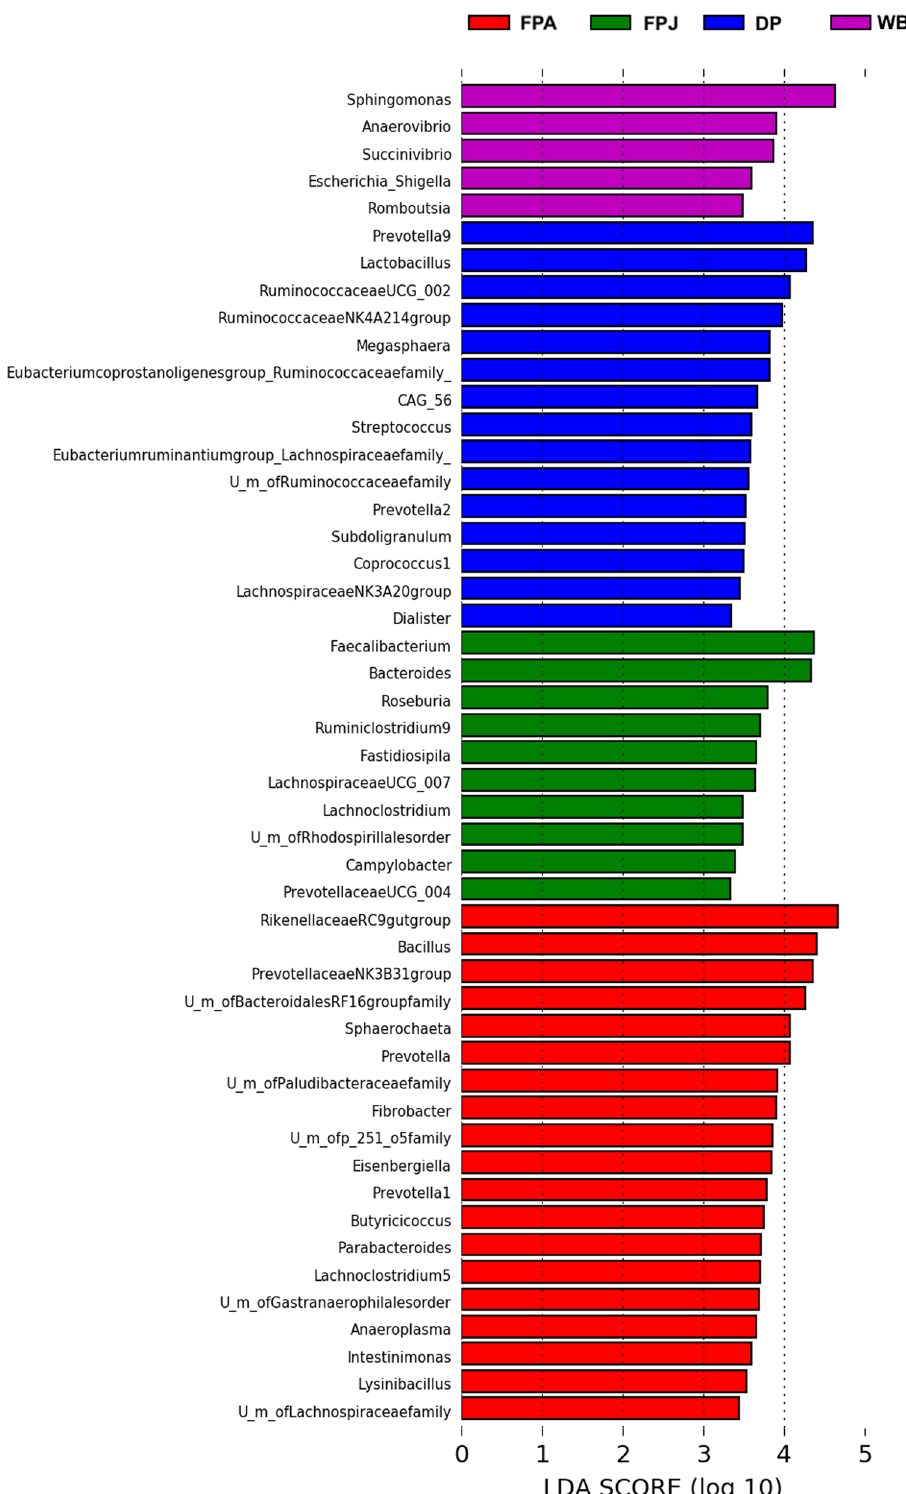
Fig. 6 LEfSe analysis. Only pathway with an LDA significance threshold > 2 are shown. Wild boar (WB), domestic pig (DP), juvenile (FPJ) and adult (FPA) feral